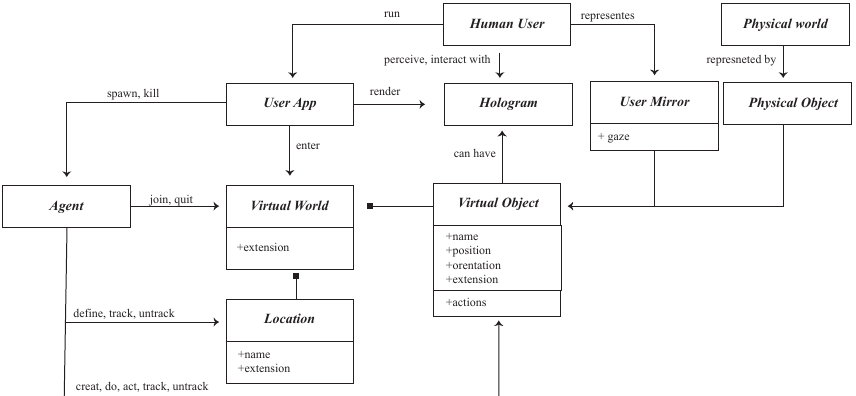
Figure 7. The concept of the co-existing human interaction process of